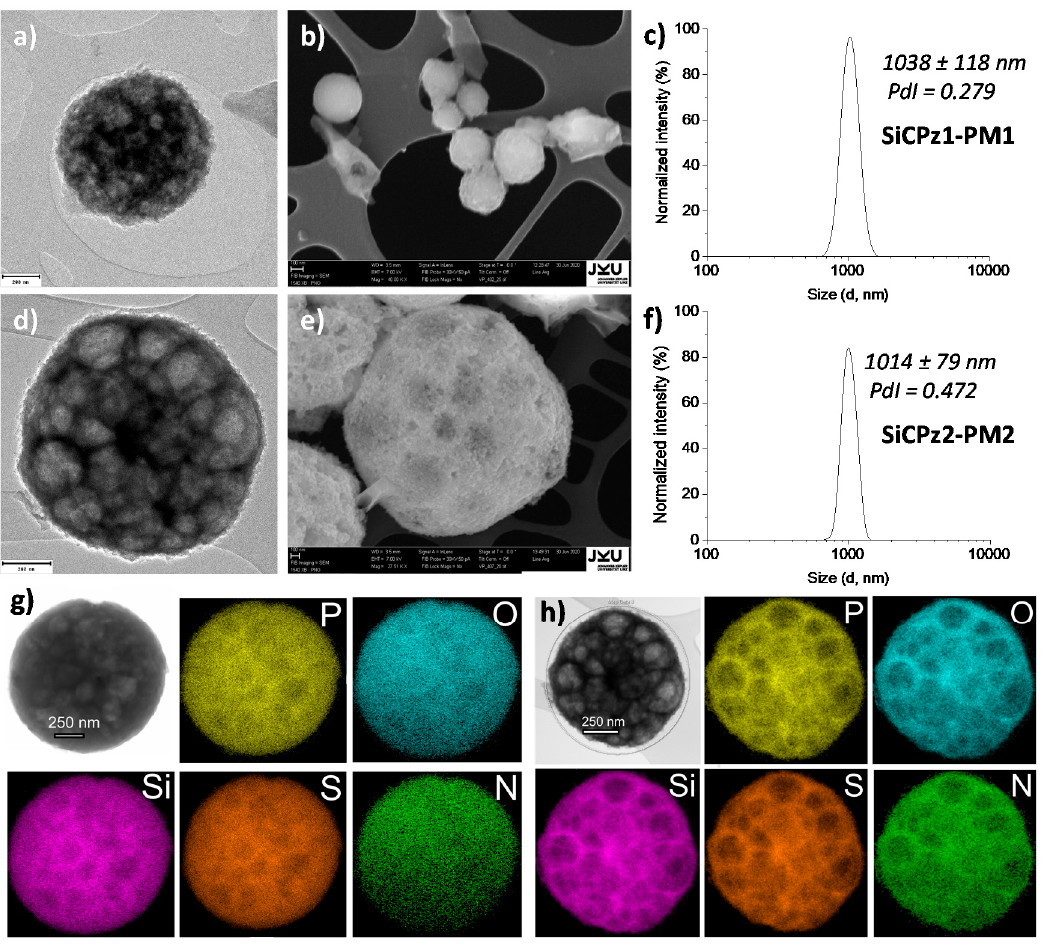
Figure 3. ( a ) TEM, SEM, and DLS measurements showing the morphology features of ( a – c ) porous organosilica microparticles SiCPz1-PM1 and ( d – f ) SiCPz2-PM2 (TEM and SEM scales 200 and 100 nm, respectively); ( g , h ) TEM-EDS elemental mapping (at %) images of ( a ) SiCPz1-PM1 and ( b ) SiCPz2-PM2, respectively (showing main elements P, O, Si, S, and N), scale = 250 nm.